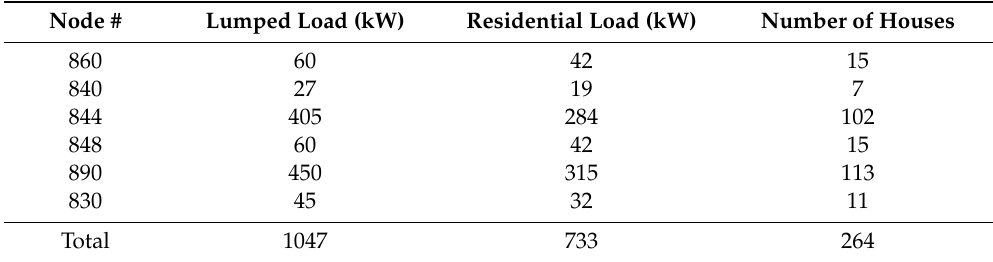
Table 5. IEEE 34 node test feeder- spot